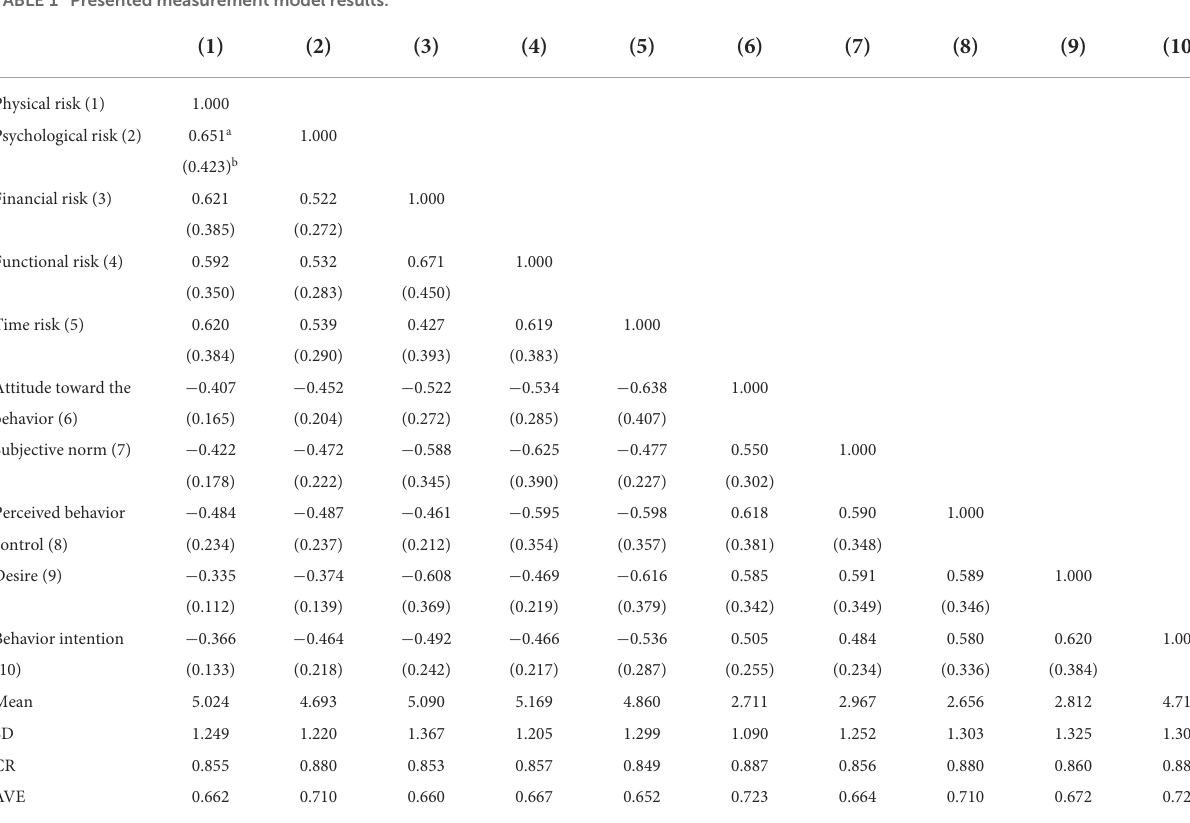
TABLE 1 Presented measurement model